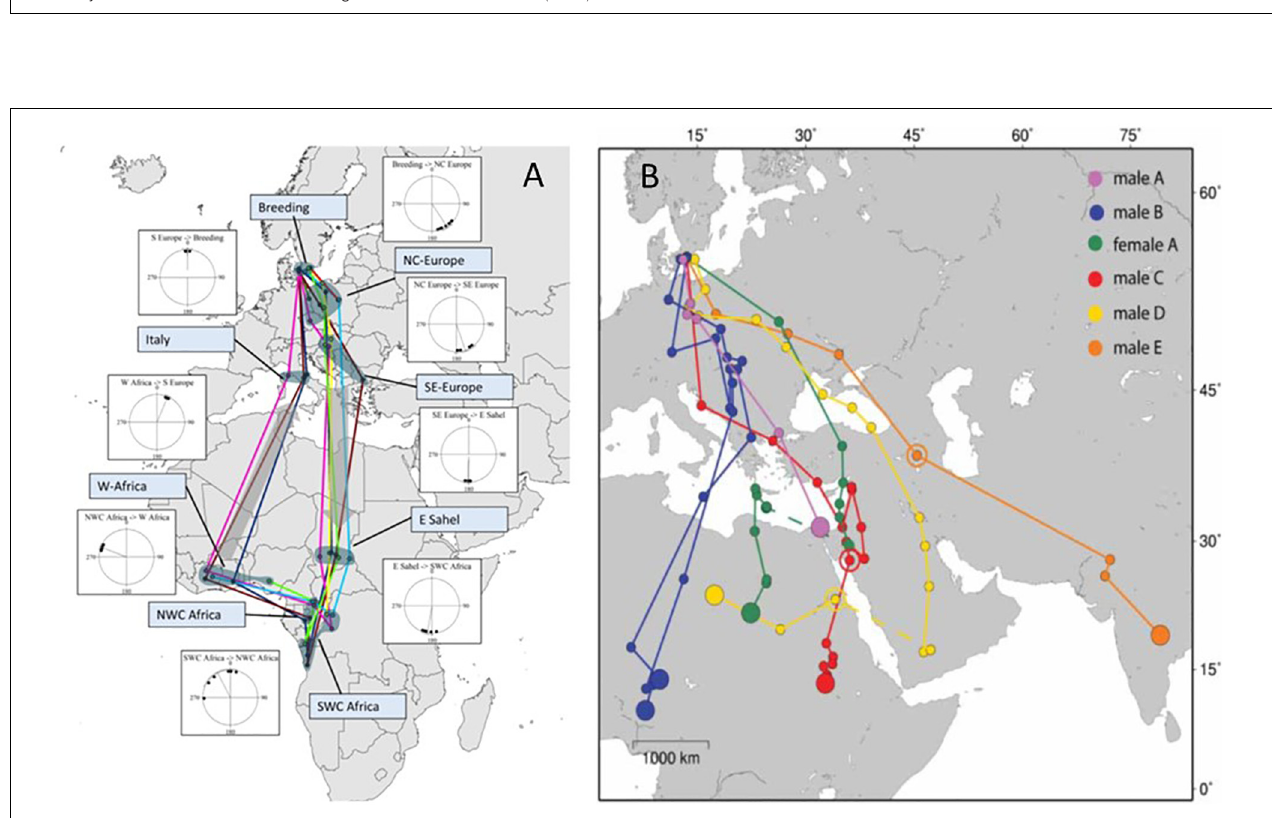
FIGURE 9 | Examples of contrasting variation in migration routes. (A) Common Cuckoo, (B) Little Ringed Plover. (A) Staging areas of eight satellite-tracked adult Common Cuckoos with vector directions between stopovers indicated by inserted orientation diagrams. Lines are connecting staging sites and do not necessarily represent the paths followed. From Willemoes et al. (2014). (B) Autumn migration tracks of Little Ringed Plovers as revealed by geolocators. Filled small circles show three-day means of positional data and filled large circles are mean location for winter positions. Open circles indicate the location of a stopover period. Broken lines indicate unknown movement around the autumn equinox. Note that one individual was tracked for two consecutive migrations using different geolocators (male B). From Hedenström et al. (2013). Maps in Mercator projection.